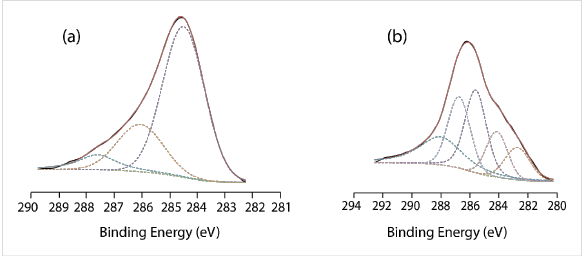
Figure 3: High-resolution XPS C 1s spectra of surfaces (a) thermally functionalized with ethynylbenzyl alcohol and (b) functionalized with ethynylbenzyl alcohol through UV